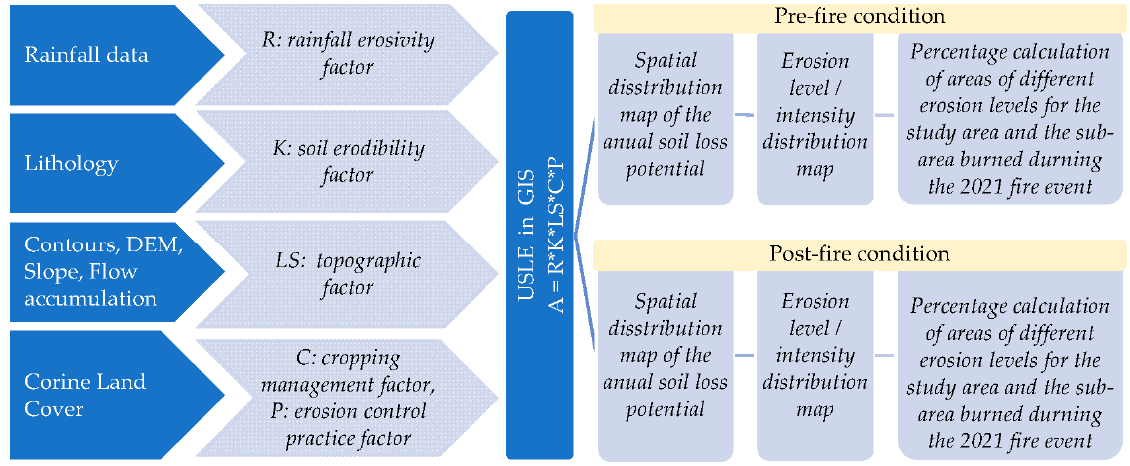
Figure 2. Schematic representation of the methodology employed.